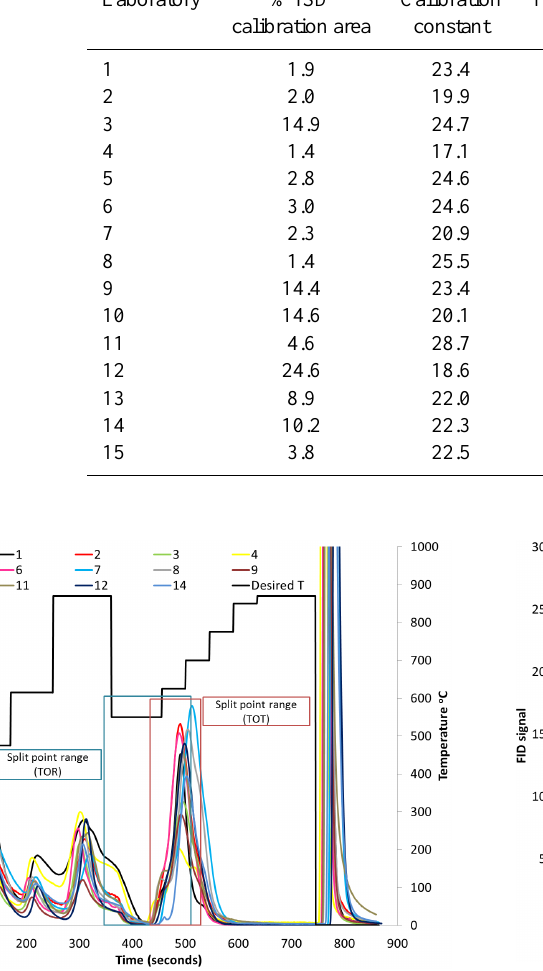
Figure 2. Thermograms of ECOC analysis on PM loaded quartz fibre filter (A sample), by NIOSH870 for all participants.